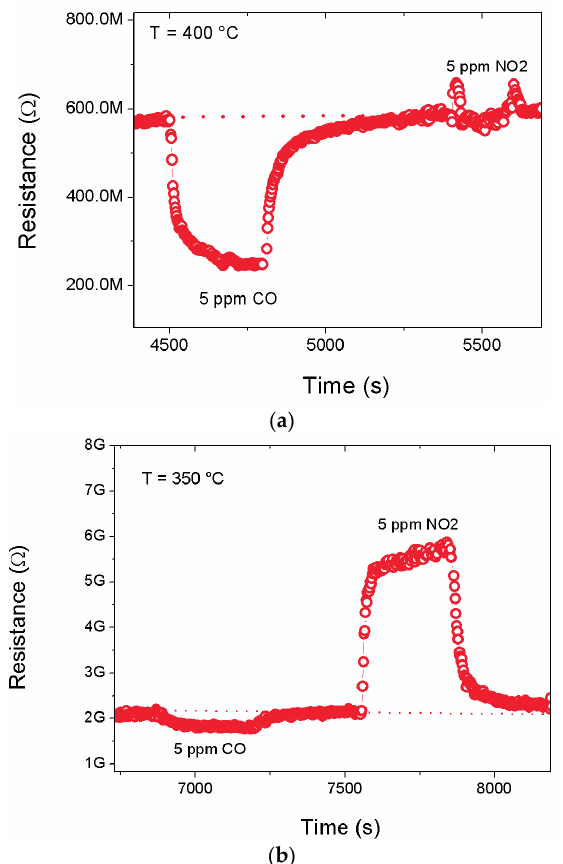
Figure 4. Variation of resistance to pulses of CO and NO 2 at two different temperatures, under a dry air (RH < 3%) flow. air (RH < 3%)